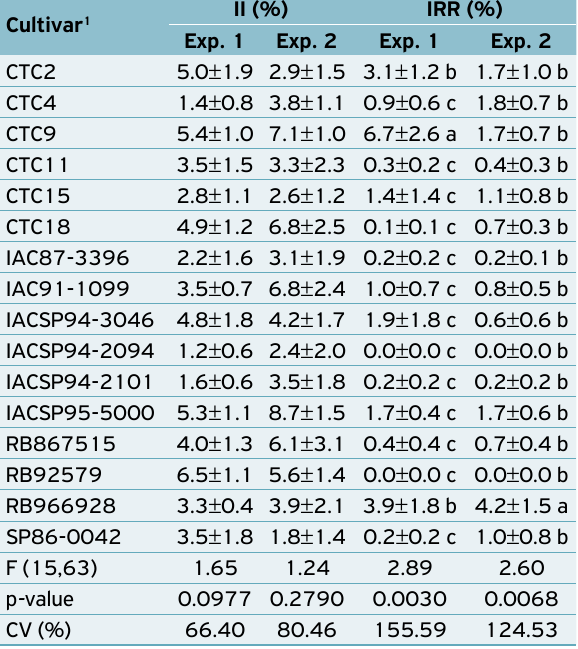
Table 2. Means ( ± SE) of infestation index (II — %) of Diatraea saccharalis and internodes with red rot (IRR — %) in 16 sugarcane cultivars. Goianésia, GO, Brazil,